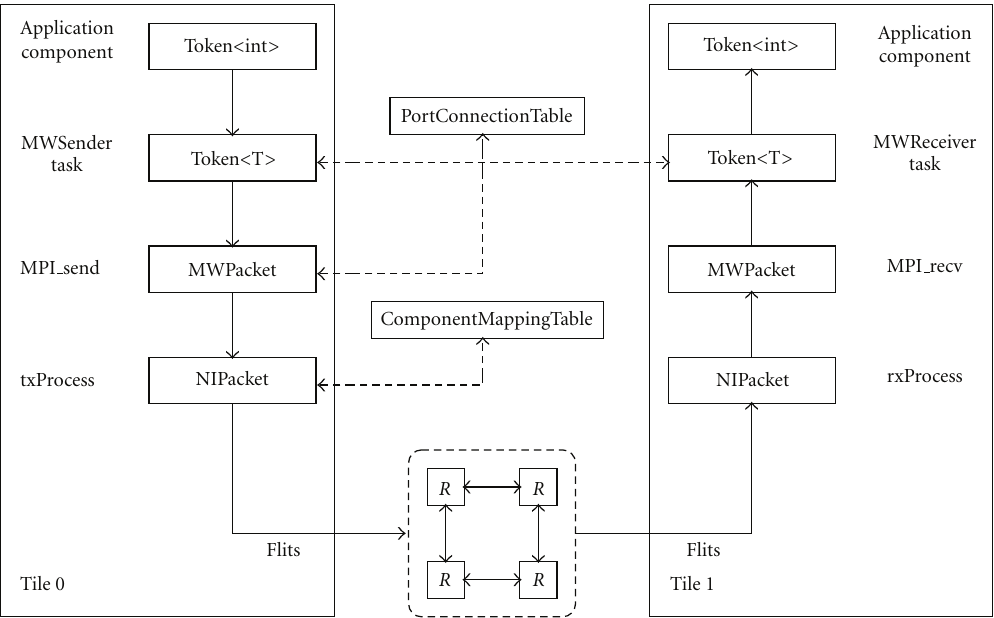
Figure 5: Implementation details of the SACRE and Noxim